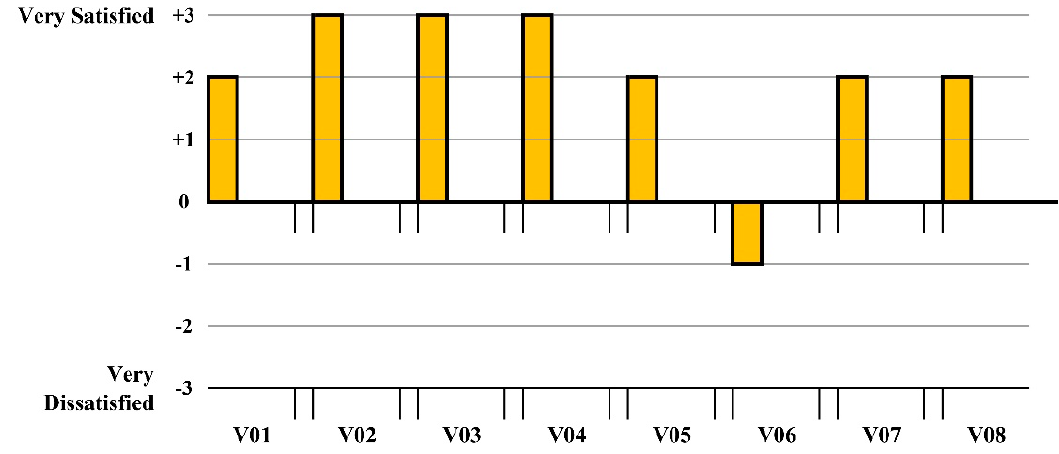
Figure 13. Visual comfort levels (lux) of the studied houses.